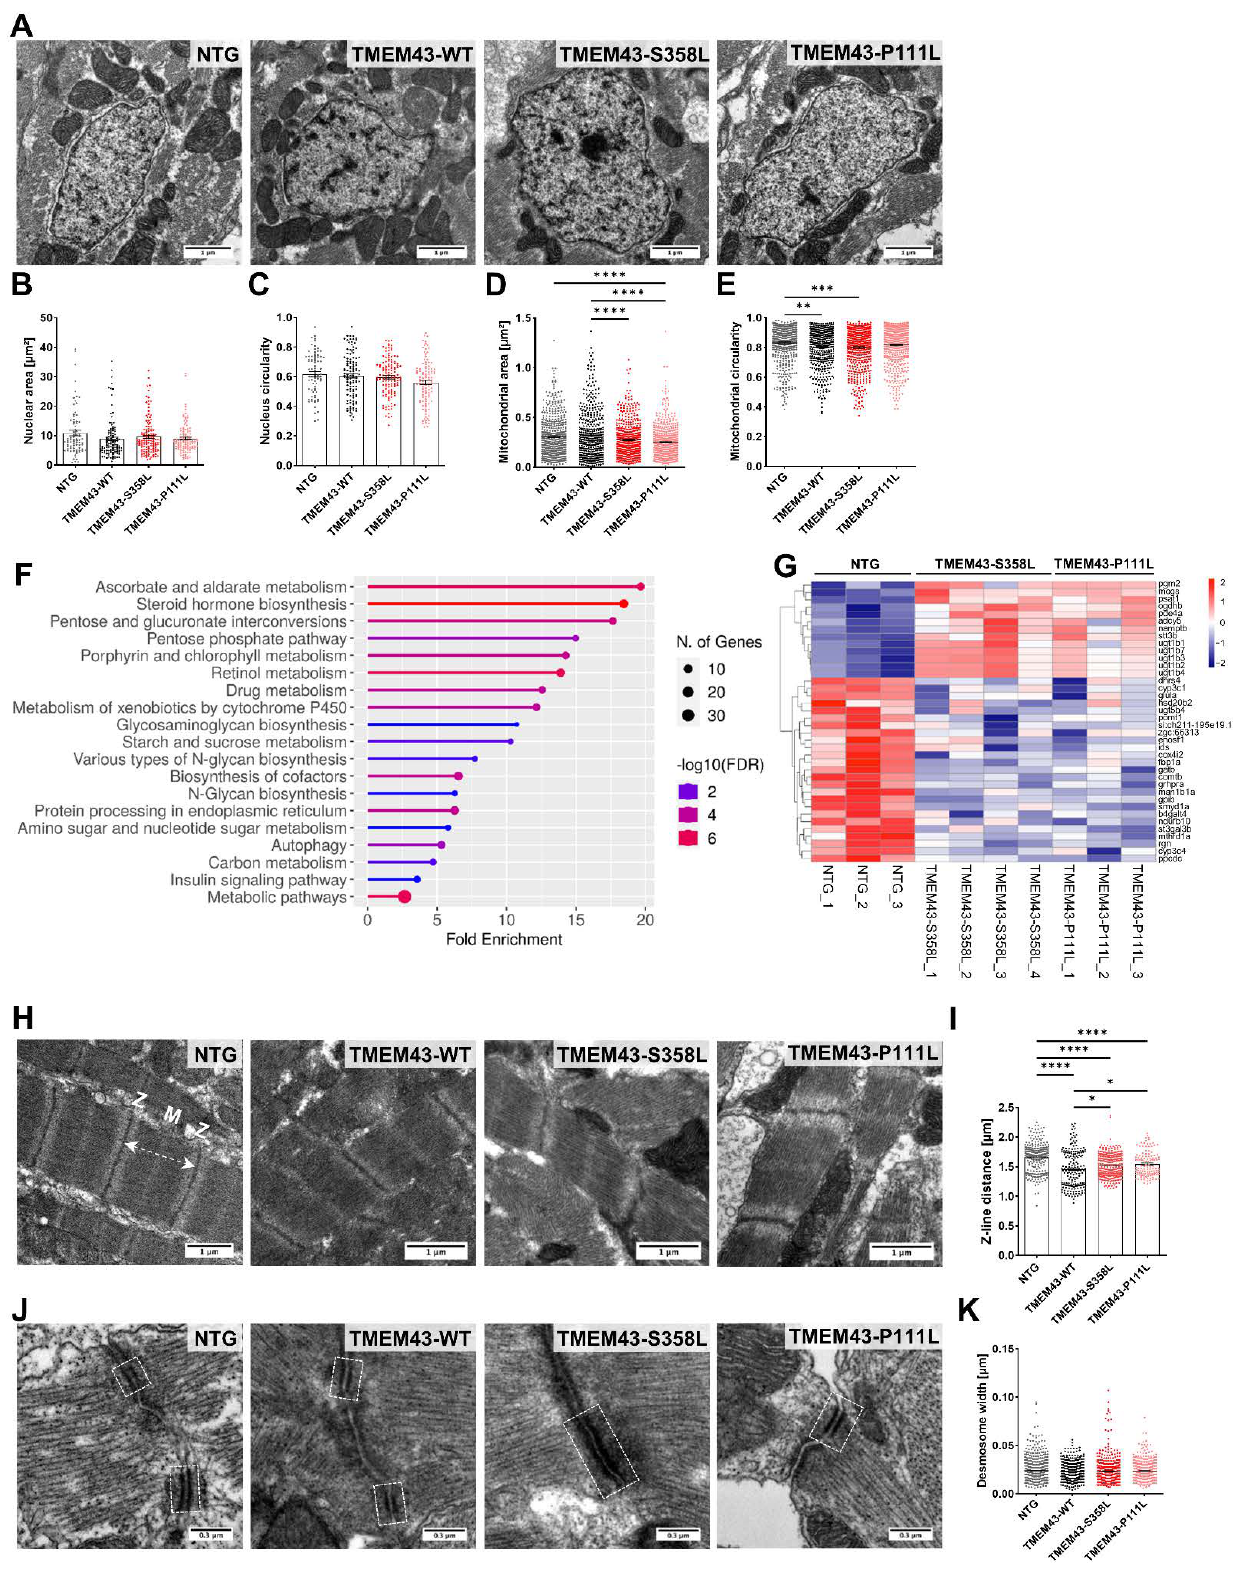
Figure 6. Transmission electron microscopy (TEM) reveals altered ultrastructure in ventricular heart tissue from TMEM43 transgenic lines at 5 months post-fertilization. ( A ) TEM images showing nuclei and mitochondria of the ventricular myocardium. Scale bars = 1 µ m. ( B ) Analysis of the nuclear